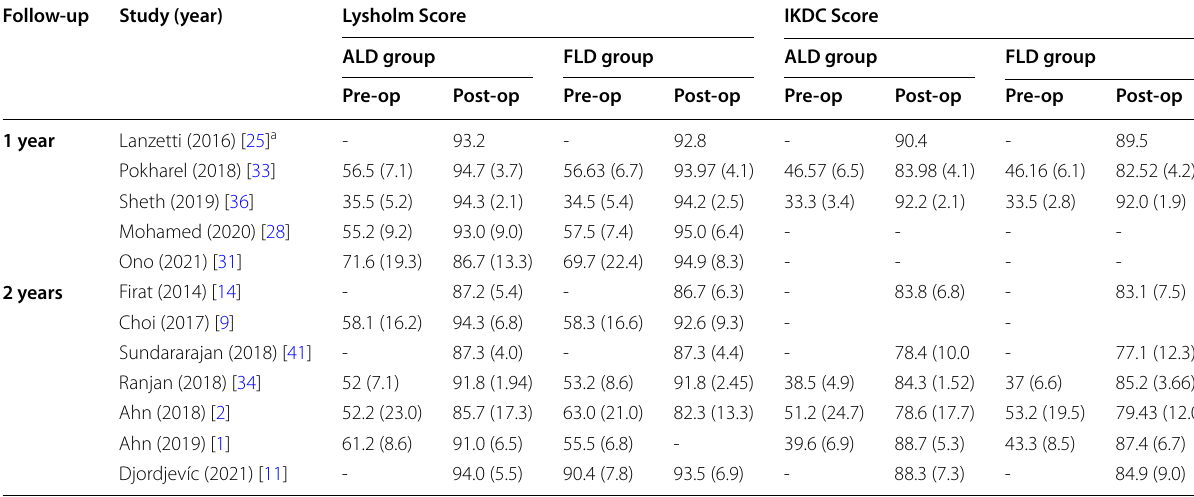
Table 4 Lysholm and IKDC scores at 1 and 2-years